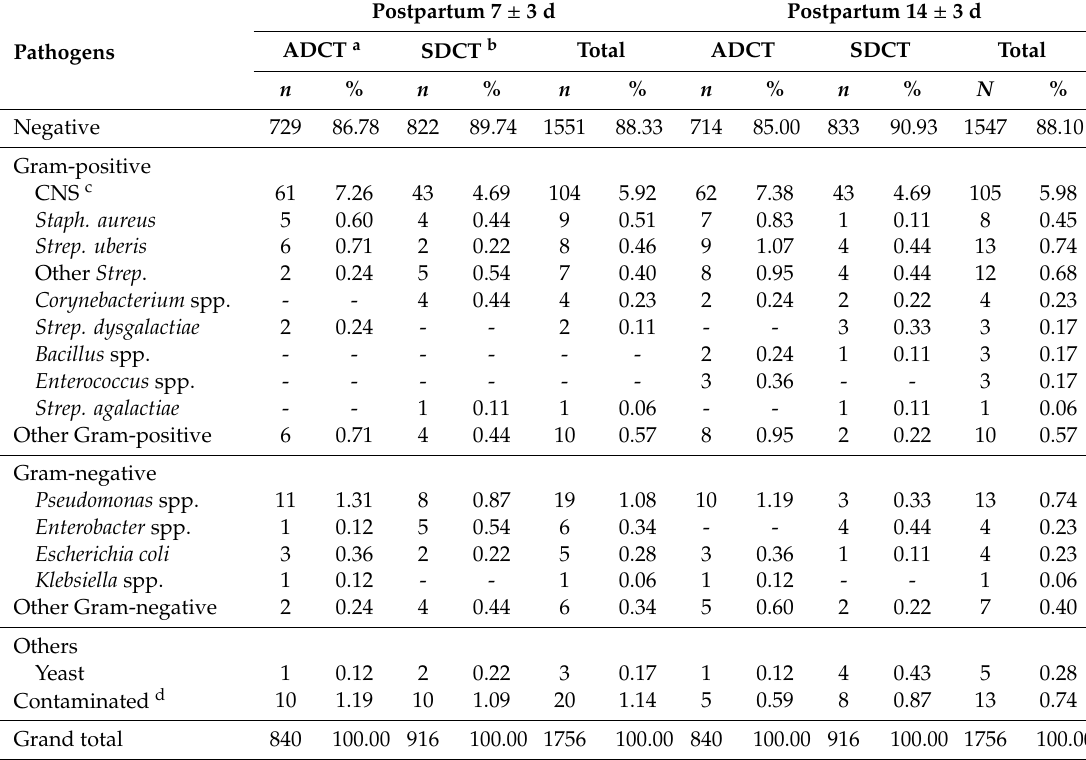
Table 3. Frequency of bovine mastitis pathogens isolated from quarter milk samples collected at 7 ± 3 and 14 ± 3 d postpartum according to DCT protocols administered at drying o ff .